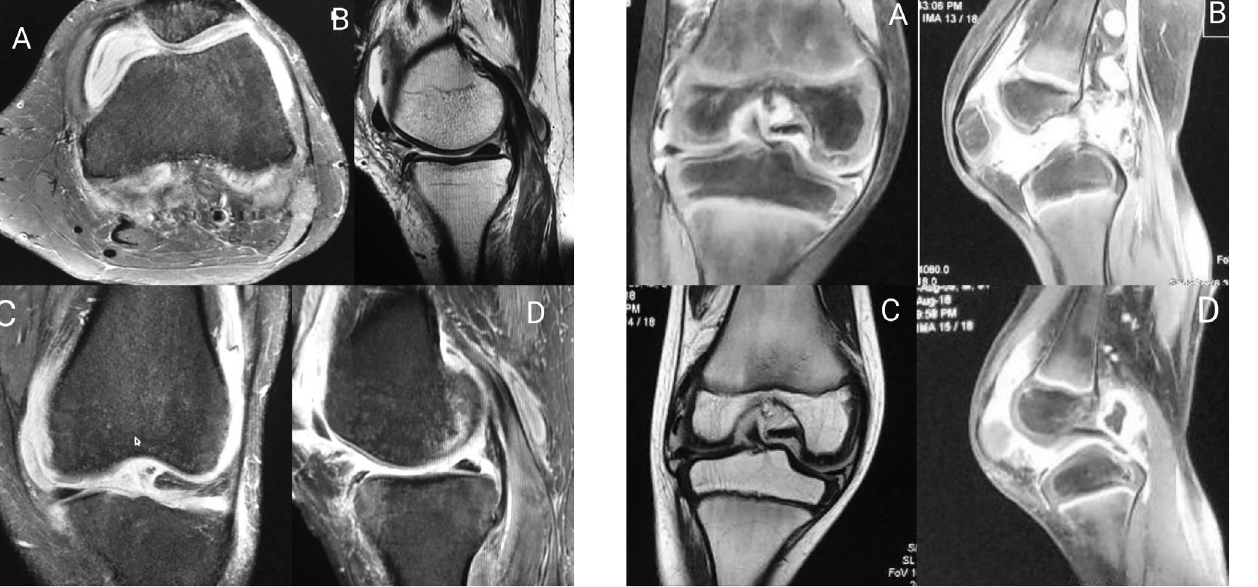
Figure 3. Figure showing MRI sections of a patient with in fl am- matory synovitis (A – axial PDFS, B – sagittal T2, C – coronal PDFS, sagittal PDFS showing hyperintensity in subarticular marrow of the tibia and femur with post-contrast enhancement and moderate effusion with diffuse enhancing synovial thickening).